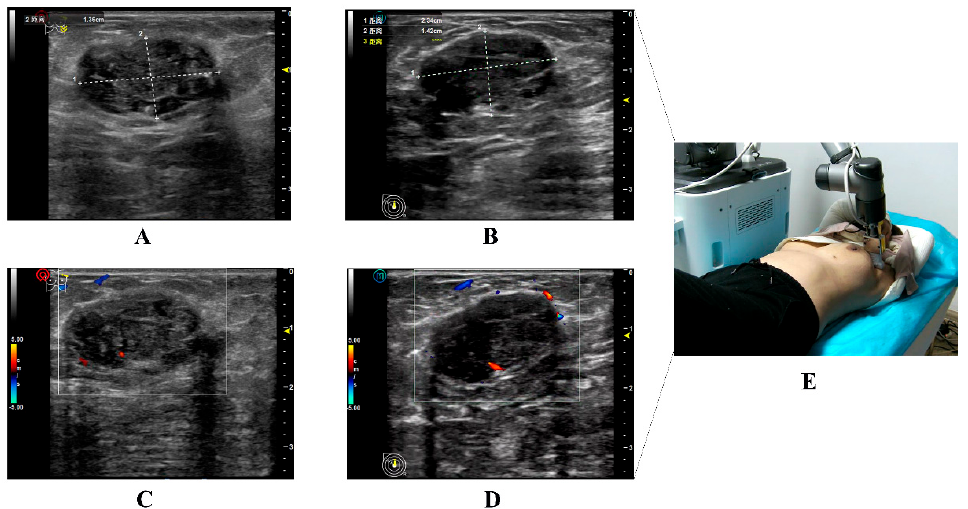
Figure 4. Illustration of the ultrasound images of the same target nodule in a 36-year-old woman obtained from conventional and 5G-based telerobotic ultrasound examinations. Grayscale US images of the same breast nodule from the ( A ) conventional US examination and ( B ) 5G-based telerobotic US examination. The US characteristics of the breast nodule are as follows: oval shape, parallel orientation, circumscribed margins, hypoechoic echo pattern, and posterior shadowing with no calcifications. The nodule is classified as BI-RADS 4. Colour Doppler flow images are from the ( C ) conventional US examination and ( D ) 5G-based telerobotic US examination. There are blood flow signals detected inside this breast nodule. ( E ) The transducer is located in the outer upper quadrant of the left breast. (US, ultrasound; 5G, fifth generation; BI-RADS, Breast Imaging Reporting and Data System) .